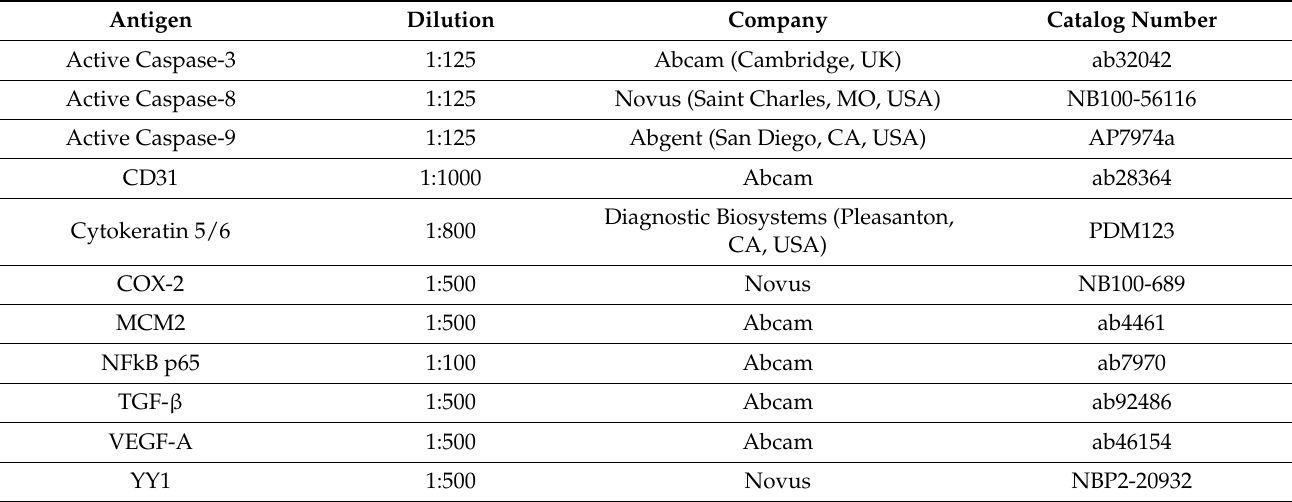
Table 4. Antibodies used for protein detection by